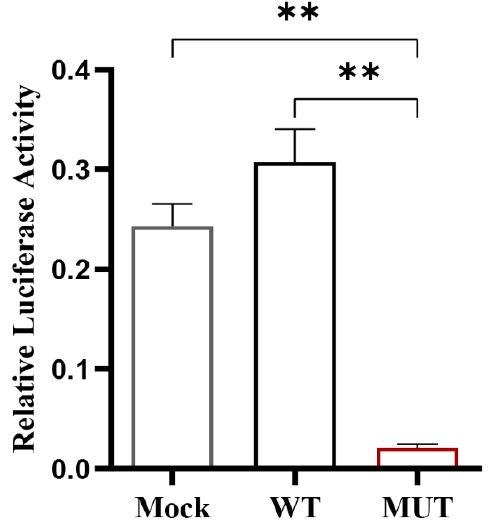
Figure 4. Effect of mC-7 site mutation on luciferase activity of the CXCL11 gene promoter. Mock: empty plasmid pGL3-Basic; MUT: recombinant plasmid treated with mutation of the mC-7 site (pGL3-Basic-MUT). WT: recombinant plasmid not treated with the original sequence of the mC-7 site (pGL3-Basic-WT). The promoter sequence that was examined was present in both the MUT group and the WT group. ** p <